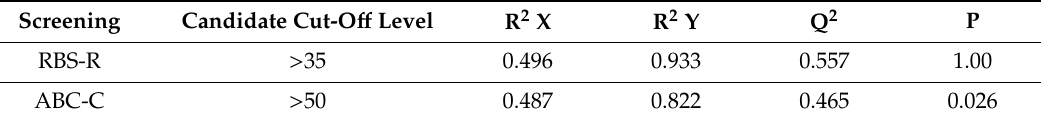
Cut-off level: candidate threshold discriminating severe from mild-to-moderate abnormal behaviors. RBS-R: Repetitive Behavior Scale-Revised. ABC-C: Aberrant Behavior Checklist-Community. R 2 X: direction of the maximum covariance between a dataset. R 2 Y: class membership. Q 2 : cross-validated predictive ability . P: cross-validation analysis of variance.